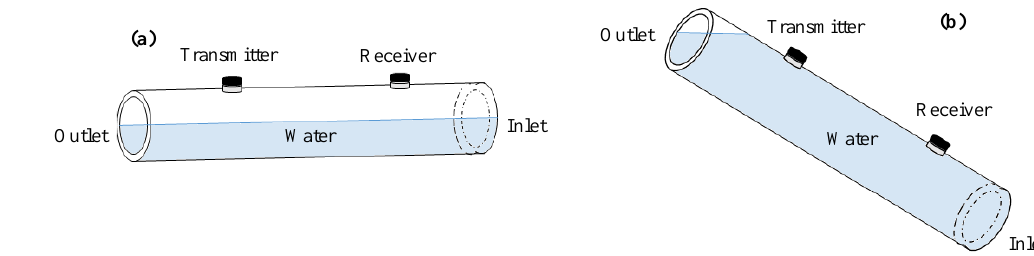
Figure 10. Schematic representation of ( a ) half-filled pipe and ( b ) fully filled pipe. For this test, a linear chirp signal from 20 to 100 kHz with a 0.5 ms duration is used, and the response is acquired with a 1.2 ms time window. Figure 11 shows the test result of magnet perturbations on the half-filled and fully filled pipes with stagnant water without using the EOC compensation method. It is seen that the AO with the compressional excitation shows a good sensitivity to the magnet perturbations. However, the measurements with the shear excitation for the half-filled pipe have a large experimental error and include a relatively high level of spurious signals. These measurements indicate that even the static liquid boundary, due to stagnant water, might necessitate the implementation of EOC compensation methods to use the right time and frequency filtering and phase-correction, which is realized by the proposed compensation methods.